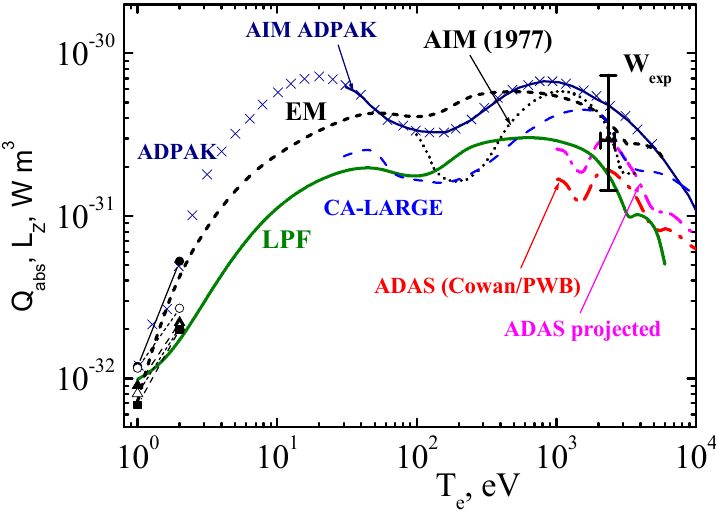
Figure 9. Comparison of radiation losses on tungsten impurity within universal statistical approach (EM—electromagnetic method, LPF—method of local plasma frequency) with results of known codes versus plasma temperature: ADPAK—[6]; AIM ADPAK